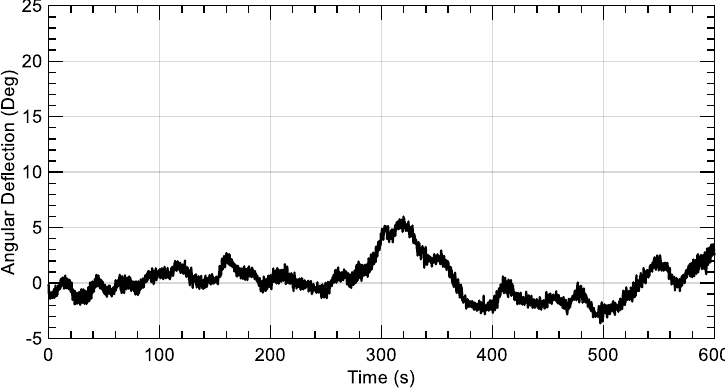
Figure 27. Tower top yawing deflection: turb. class A.